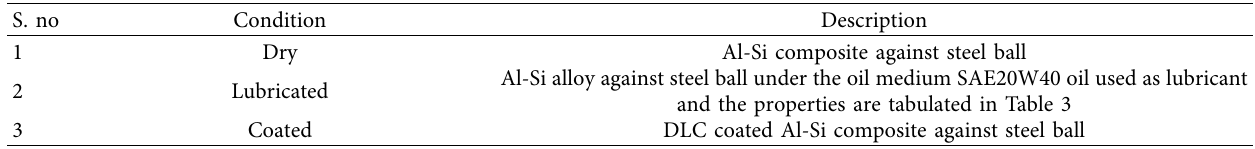
Table 2: Various conditions tested for the Al-Si alloy.